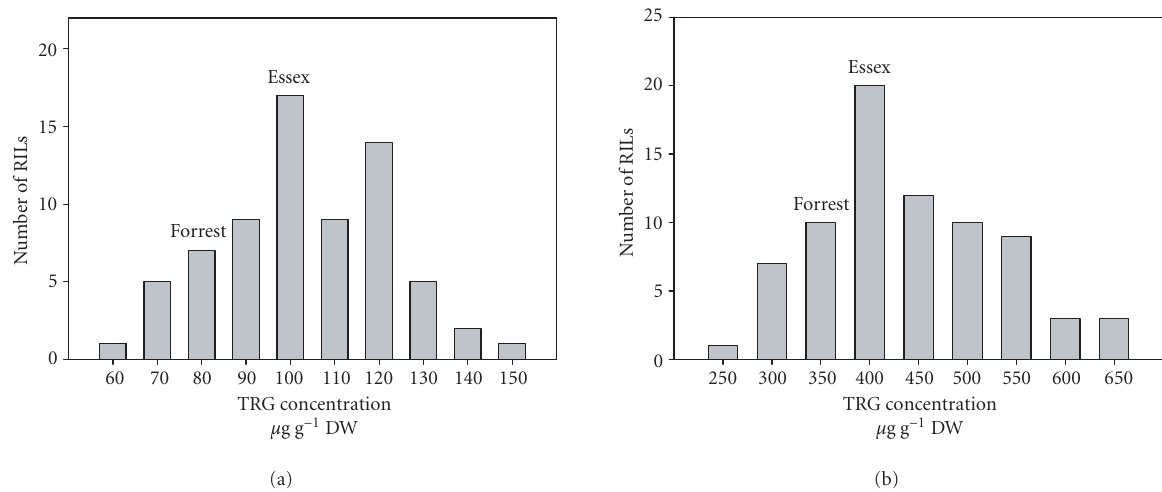
Figure 1. Trigonelline (TRG) concentration and normal distribution of RILs derived from a cross of Essex with Forrest. The mean trigonelline concentration for individual parents is presented. (a) Frequency distribution of TRG estimated on the basis of fresh weight of leaf sampled at pod setting stage; (b) on the basis of dry weight of leaf.